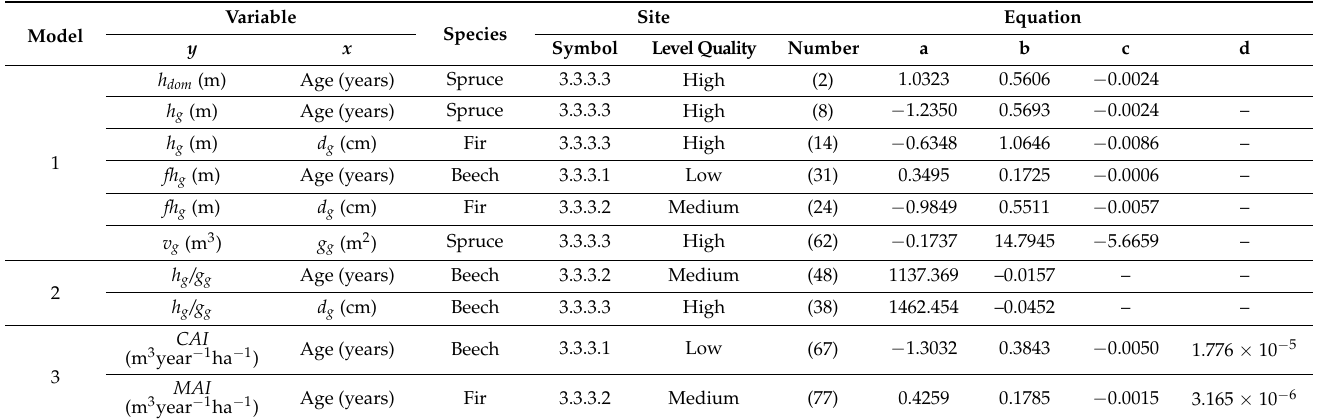
Table 3. Statistical descriptors of